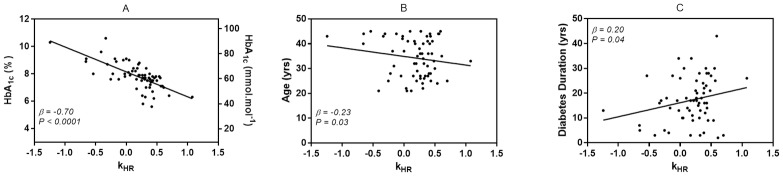
Single plots of the association of kHR and HbA1c (A), age (B) and diabetes duration (C).kHR = degree and direction of the heart rate to performance curve.